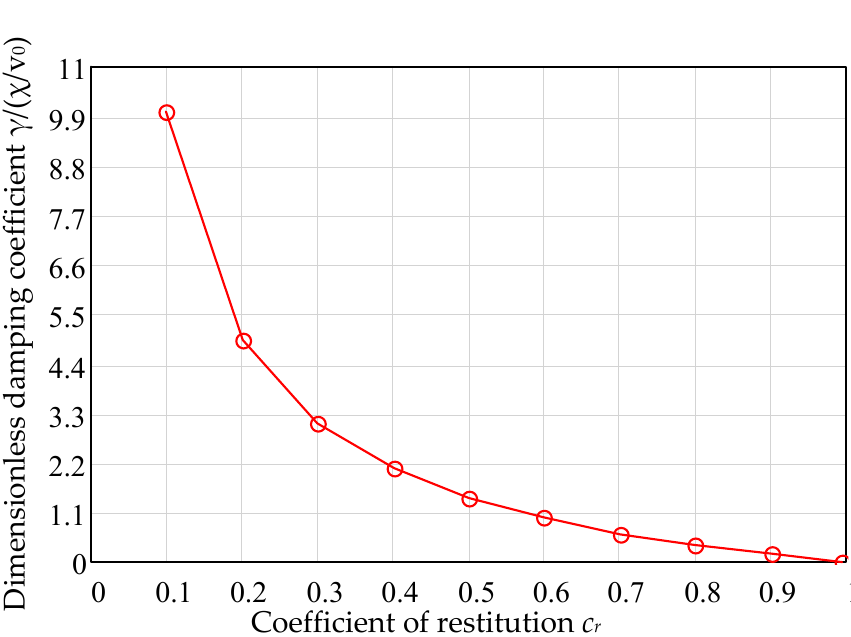
Figure 26. Dependency of coefficient of damping force ( γ ) on coefficient of restitution ( c r ).